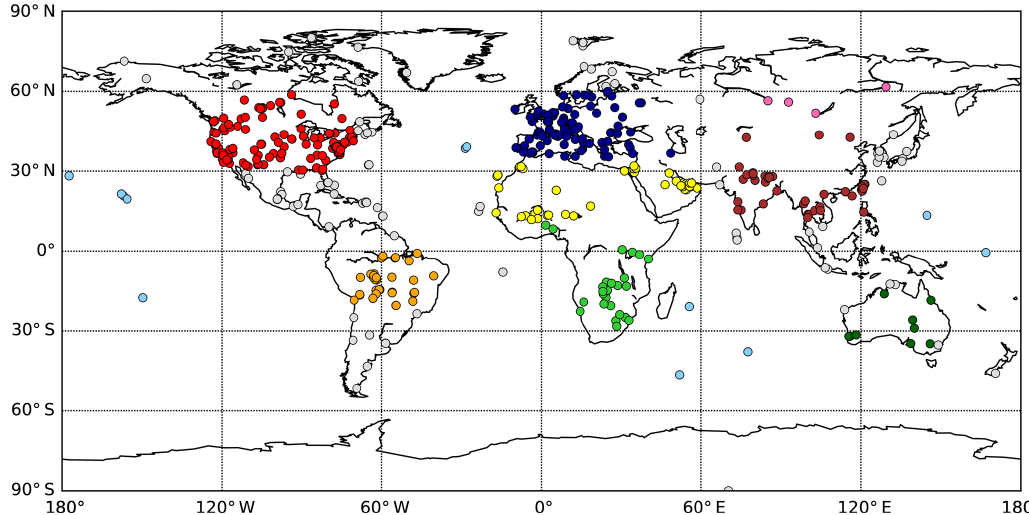
Figure 1. Locations of AERONET stations used for model evaluation. All stations are color coded according to the region to which they belong. Red: North America; dark blue: Europe; brown: East Asia; pink: Siberia; yellow: North Africa; green: South Africa; orange: South America; dark green: Australia; light blue: oceanic regions; grey: elsewhere (coastal and mixed).